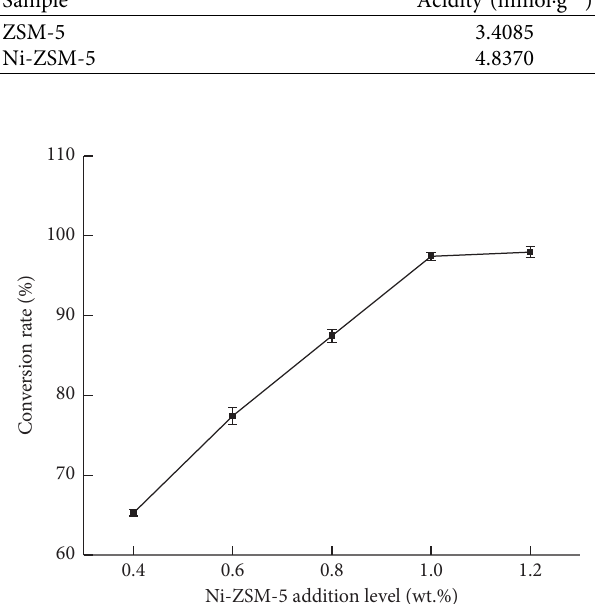
Figure 7: Effects of the Ni-ZSM-5 addition level on the conversion rate of unsaturated